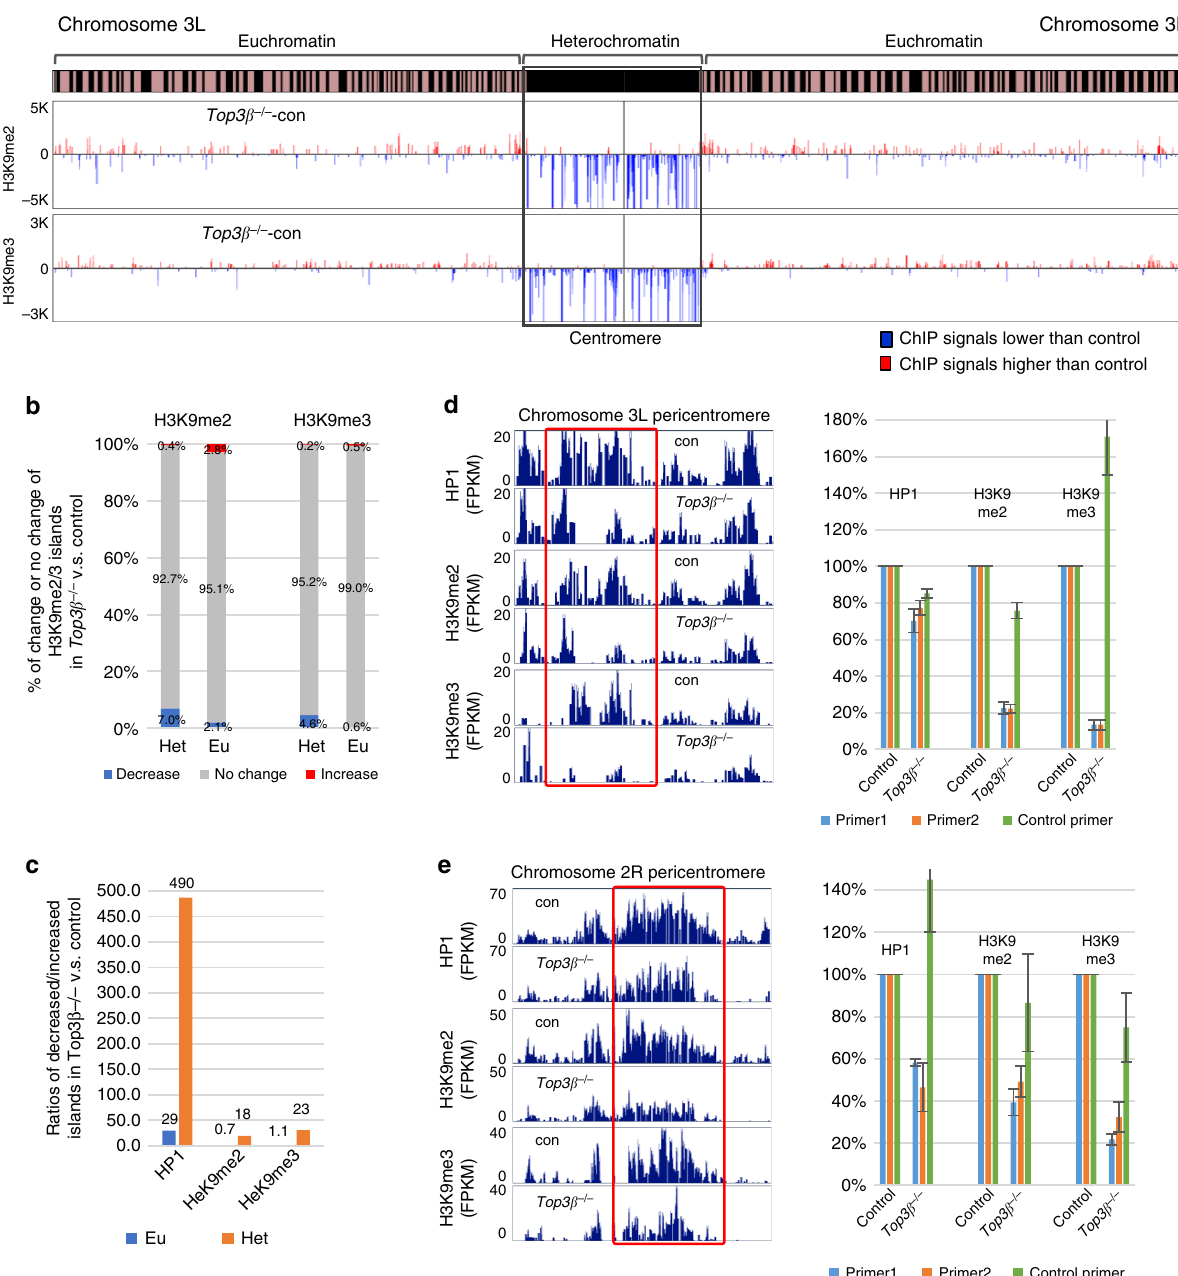
Fig. 6 Top3 β promotes H3K9 methylation and HP1 recruitment in heterochromatin. a Bedgraphs show differences of SICER scores of H3K9me2 and H3K9me3 ChIP-seq data between Top3 β mutant versus the control ( w 1118 ) for chromosome 3 ( Y -axis). Islands with decreased and increased signals are marked by blue and red, respectively. b A graph shows the percentage of H3K9me2 or H3K9me3 islands that are decreased (blue), increased (red), or of no change (gray) in heterochromatin (Het) or euchromatin (Eu) of Top3 β mutant when compared to the control. The quanti fi cation is based on SICER analysis from 3 independent ChIP experiments. c A graph shows the ratio of islands with decreased over those with increased signals of HP1, H3K9me2, and H3K9me3 in heterochromatin (red) and euchromatin (blue) of Top3 β mutant when compared to the control. The quanti fi cation for HP1 is based on 3 ChIP-seq experiments. d , e Bedgraphs of ChIP-seq data (left) and graphs of RT-qPCR (right) show that two representative pericentric heterochromatin regions on chromosome 3L and 2R have decreased signals of HP1, H3K9me2, and H3K9me3 in Top3 β mutant when compared to the control. The red box marks the region in which 2 primer pairs for qRT-PCR were selected. A pair of control primers was selected from the euchromatin of the corresponding chromosomes. The results of RT-qPCRs were from triplicates. The error bars are obtained by standard error